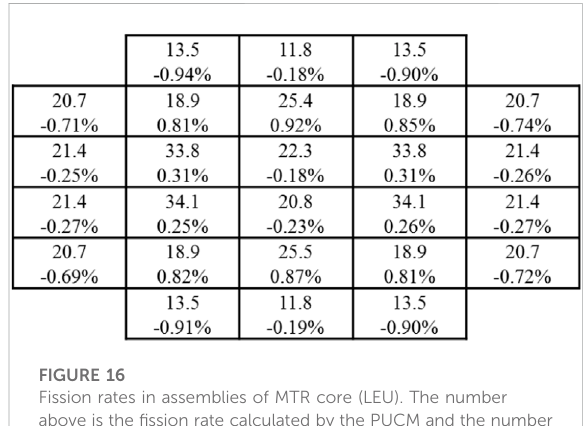
FIGURE 17 The relative error of plate-wise fi ssion rates in MTR core (LEU), unit in %.